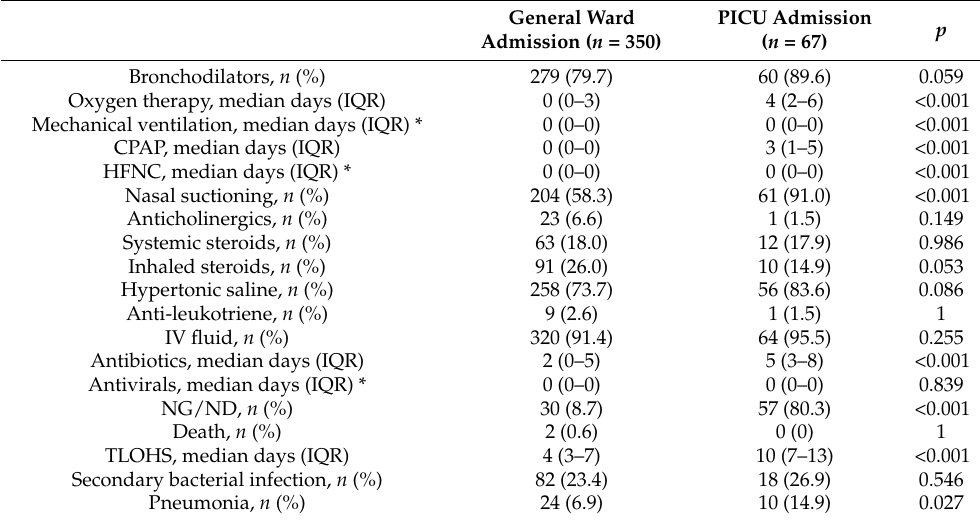
Table 5. Patient management and complications according to admission